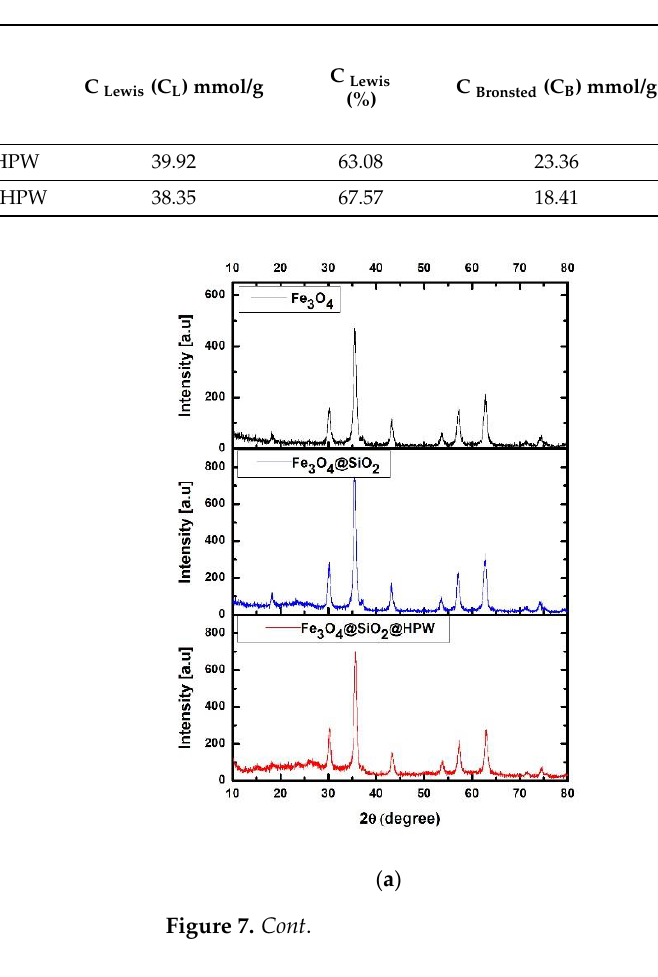
Figure 6. FTIR spectra of the catalyst with and without pyridine. Table 2. The concentration of acidic sites.